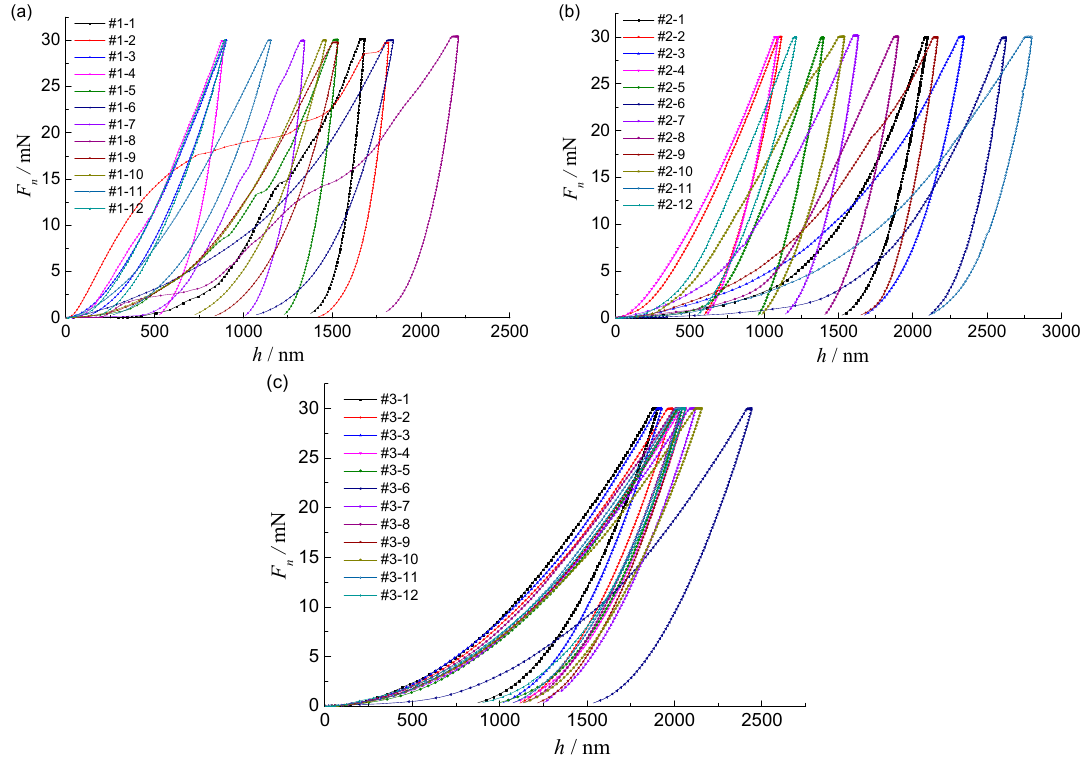
Figure 5. Load–depth curves of ( a ) shale, ( b ) mudstone and ( c ) coal.